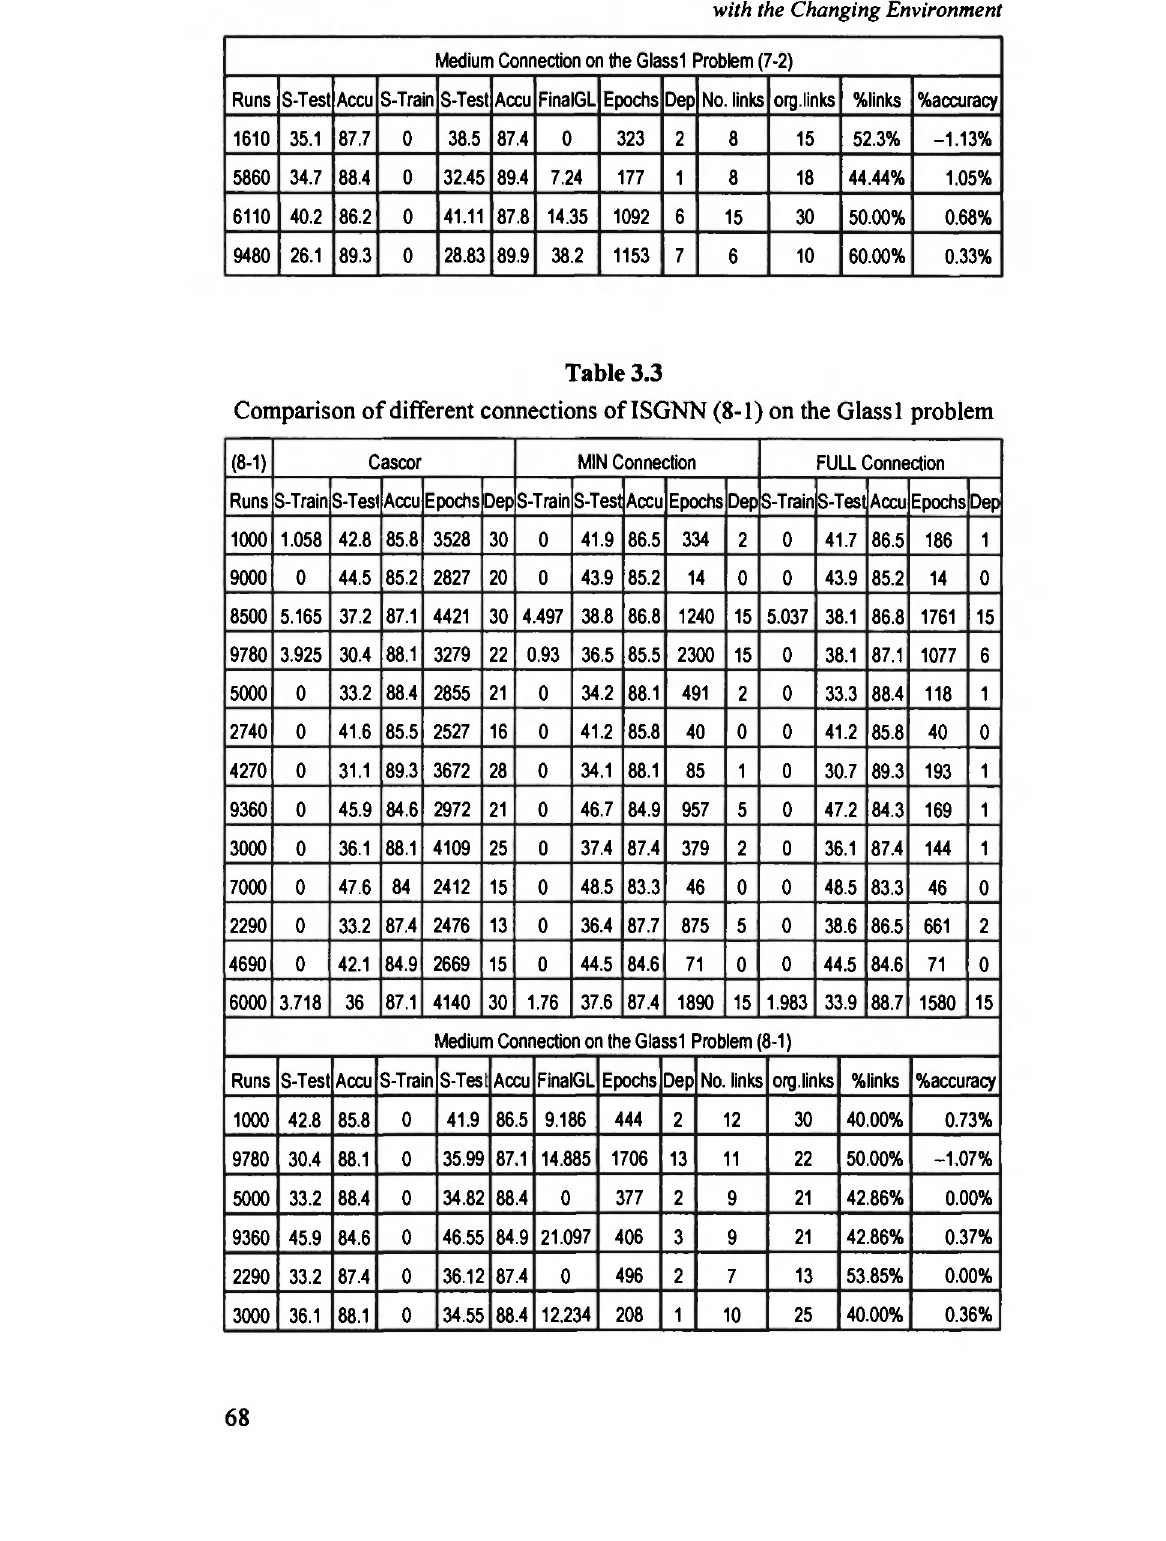
Comparison of different connections of ISGNN (8-1) on the Glass 1 problem Cascor MIN Connection FULL